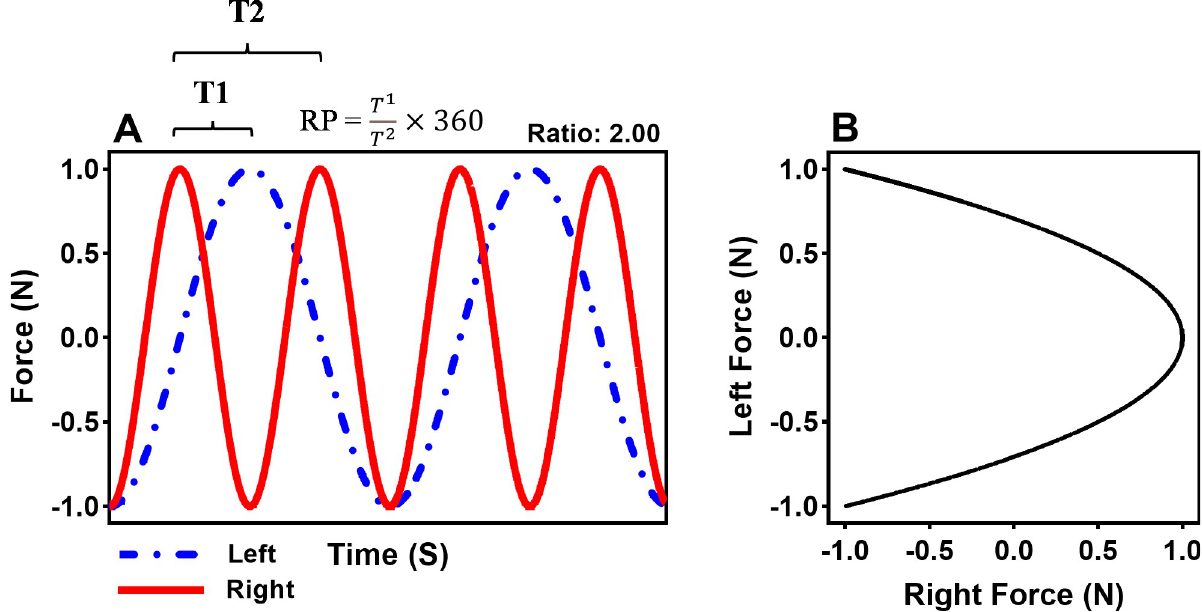
Fig 2. Task description. (a) Simulated goal coordination pattern for non-dominant and dominant limb during 1:2 coordination task, with (b) corresponding Lissajous template for 1:2 task. Note, the calculation for relative phase is also included.